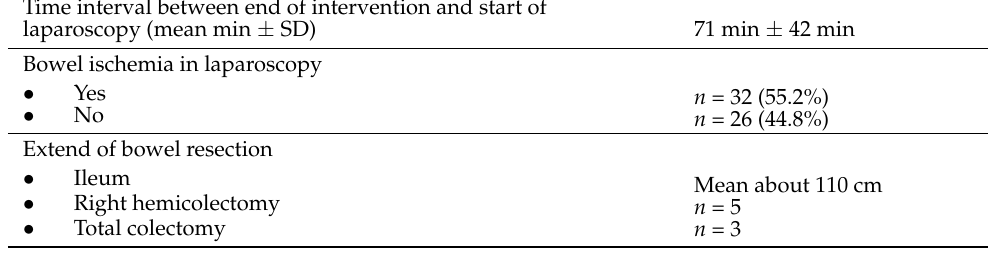
Table 4. Results of surgical follow up after intervention.